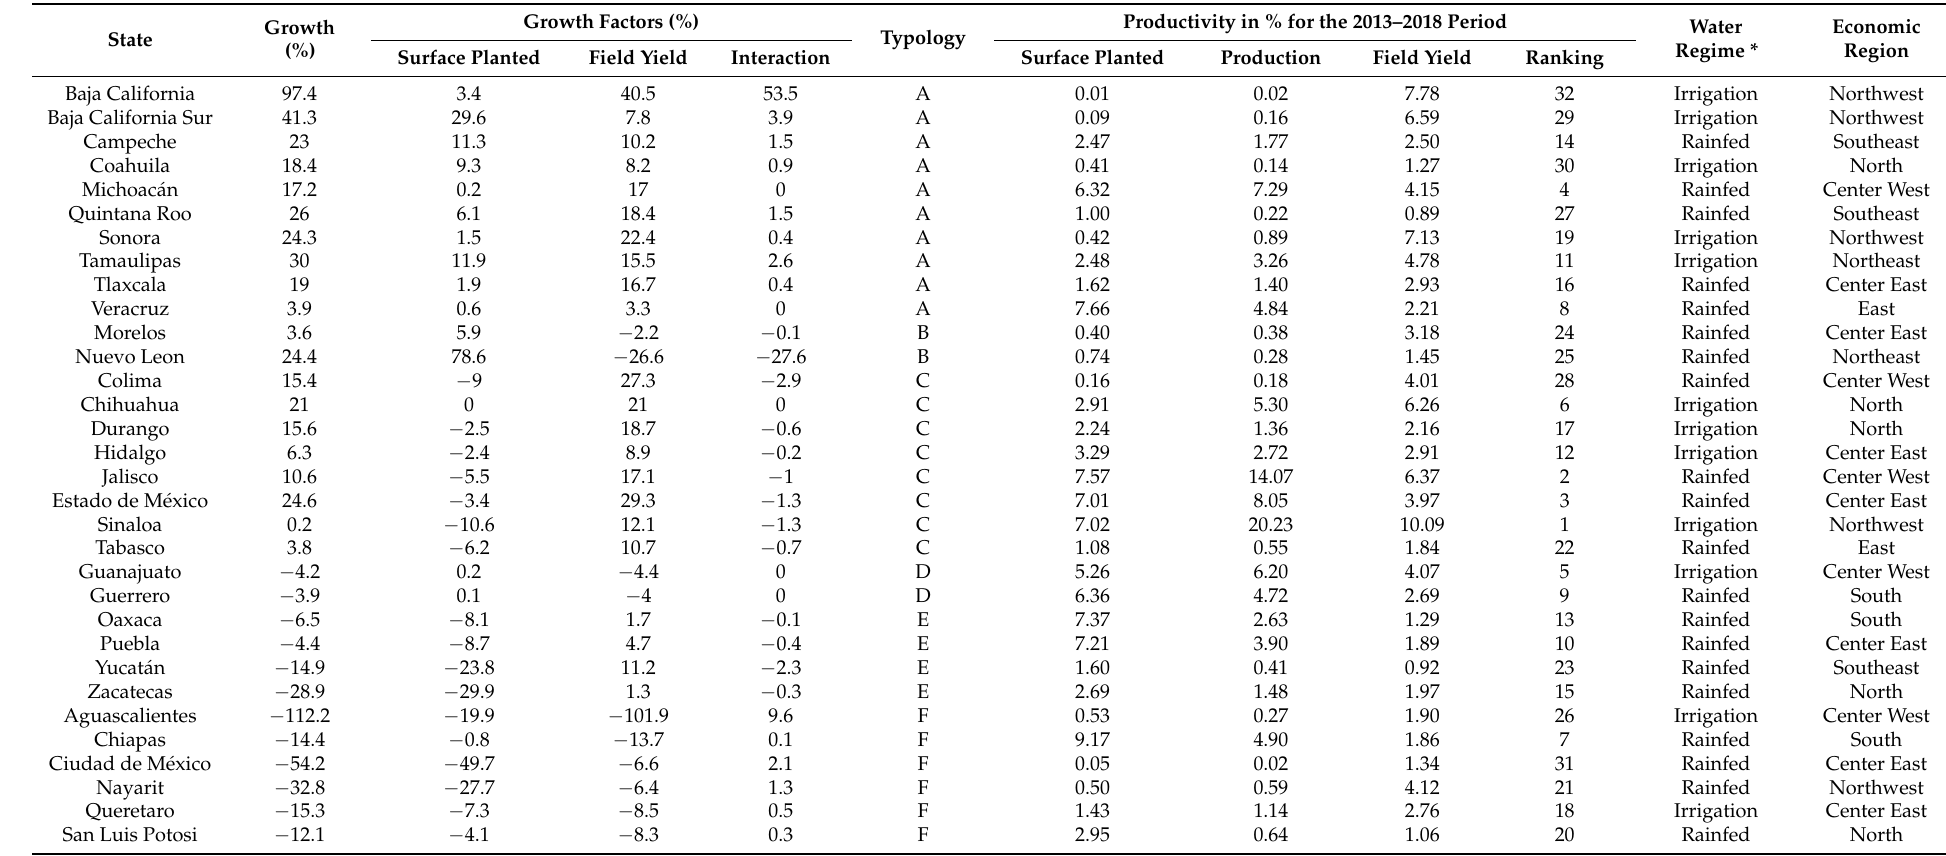
Table 6. Grain maize productivity by state in 2013–2018 compared to 2007–2012 obtained through the decomposition of production growth factors model. Growth Factors (%) Growth State (%)